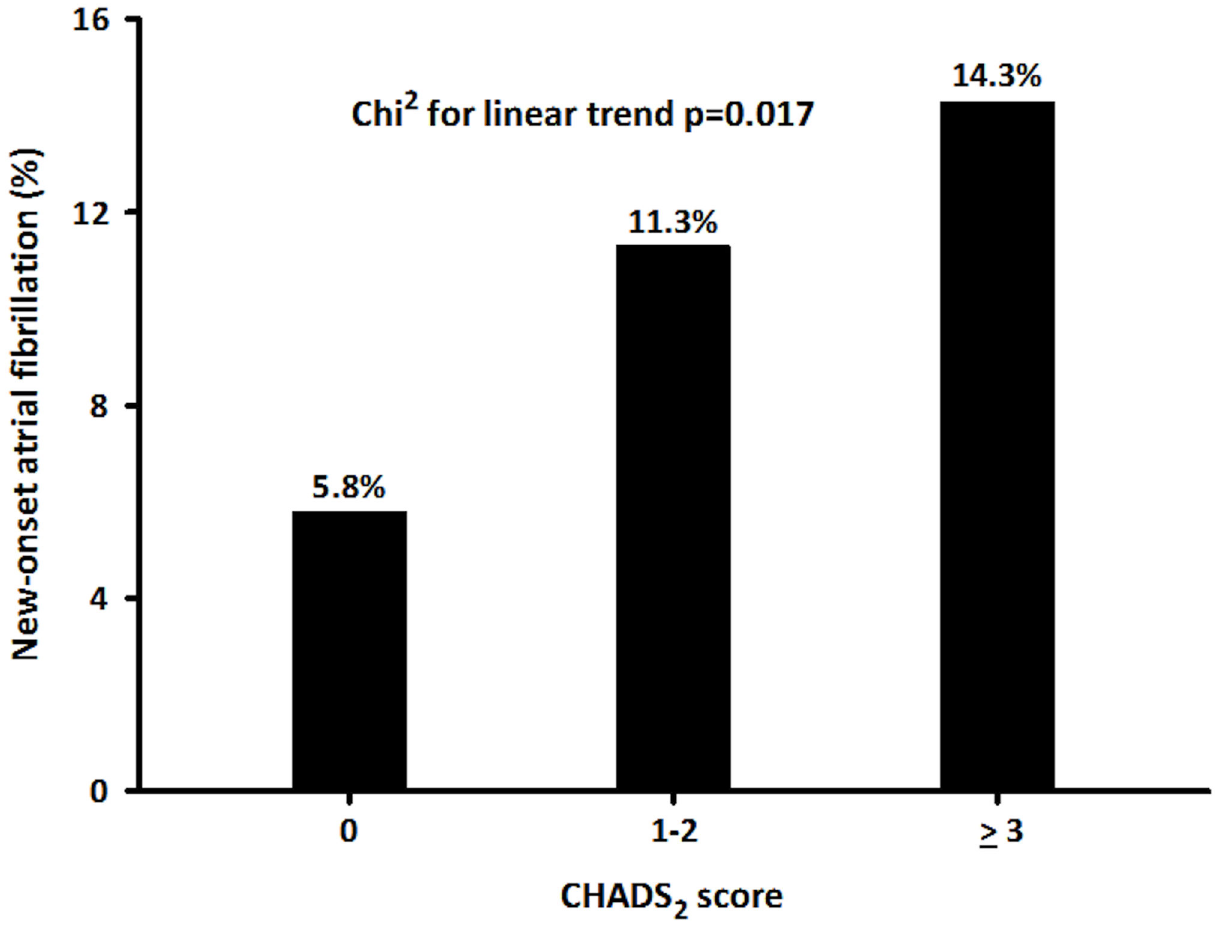
Figure 1. Incidence of new-onset AF in AMI patients according to CHADS